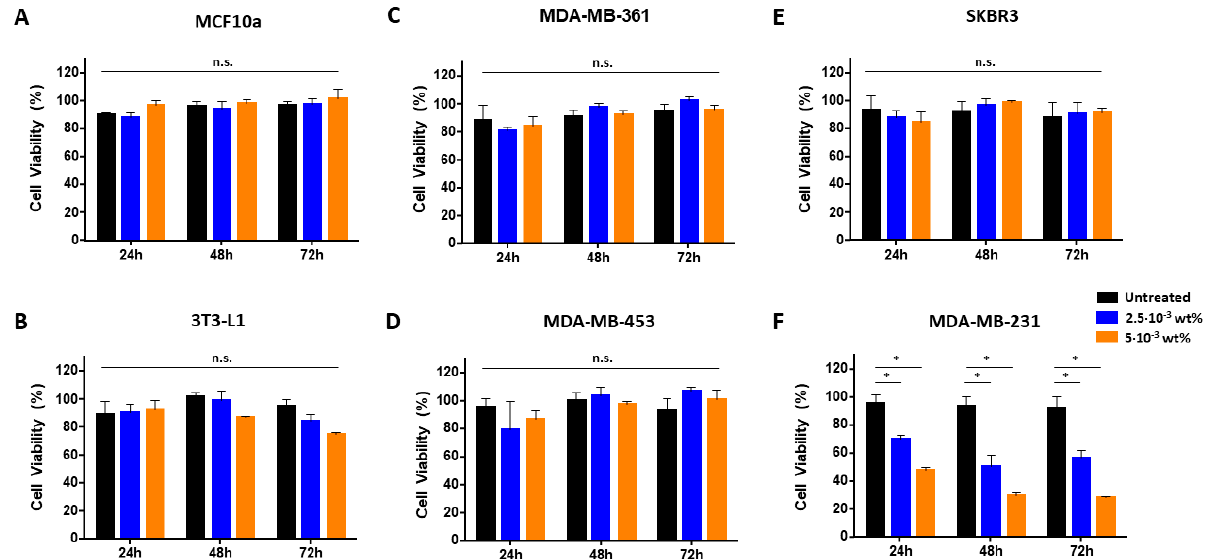
Figure 2. Fmoc-FF nanogels exert a cytotoxic effect on MDA-MB-231. MTT assays were conducted on MCF10a ( A ), 3T3-L1 ( B ), MDA-MB-361 ( C ), MDA-MB-453 ( D ), SKBR3 ( E ) MDA-MB-231, and ( F ) cells upon incubation for the indicated times (24, 48, and 72 h) with two different Fmoc-FF nanogel concentrations: 5 × 10 − 3 wt% (red bars) or 2.5 × 10 − 3 wt% (green bars). Cell survival is expressed as a percentage of viable cells measured in the presence of nanogels, compared to control untreated cultures. * = p -value < 0.05. Mann-Withey t -test. n.s. = not significant.